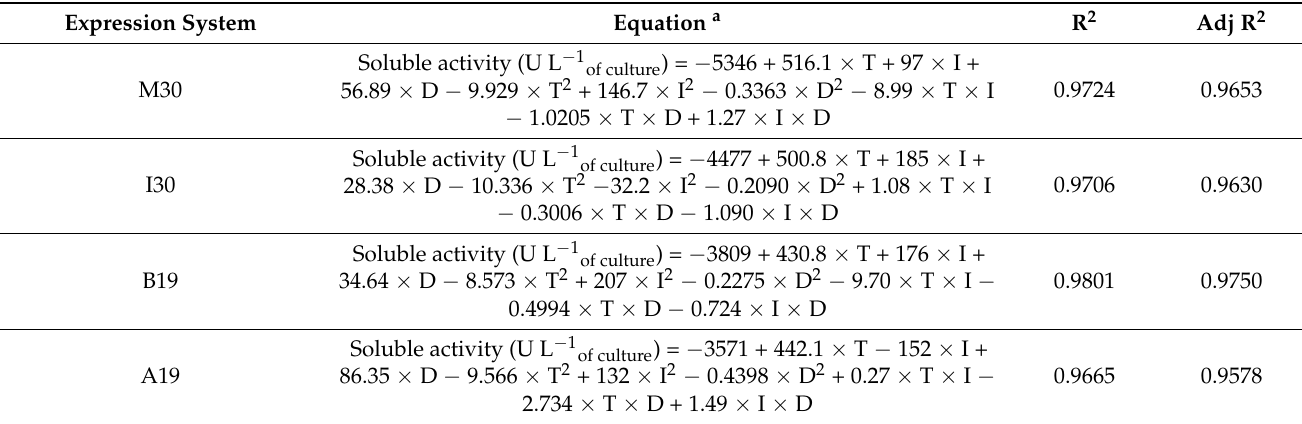
Table 1. Response surface quadratic model analysis of hydroperoxide lyase (HPL) activity level obtained with M30, I30, B19 and A19 expression system, after model simplification—second-order polynomial equations and determination coefficients. Expression